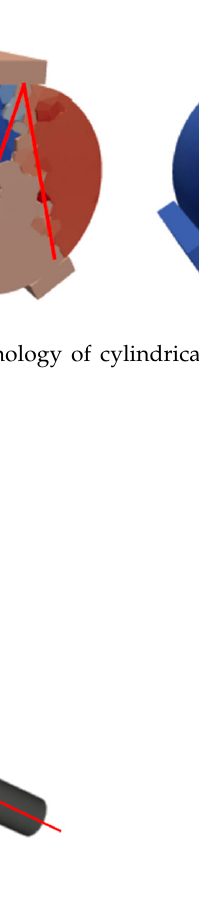
Figure 12. Fracture morphology of a cylindrical particle under three point loads.